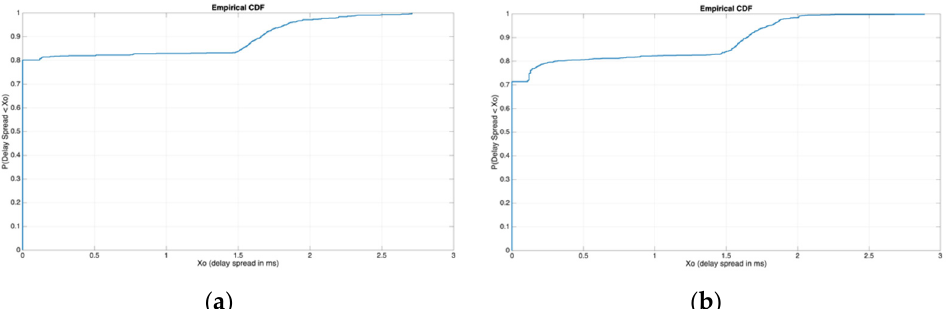
Figure 12. ( a ) NVIS delay spread distribution of the ordinary channel; ( b ) NVIS delay spread distribution of the extraordinary channel.